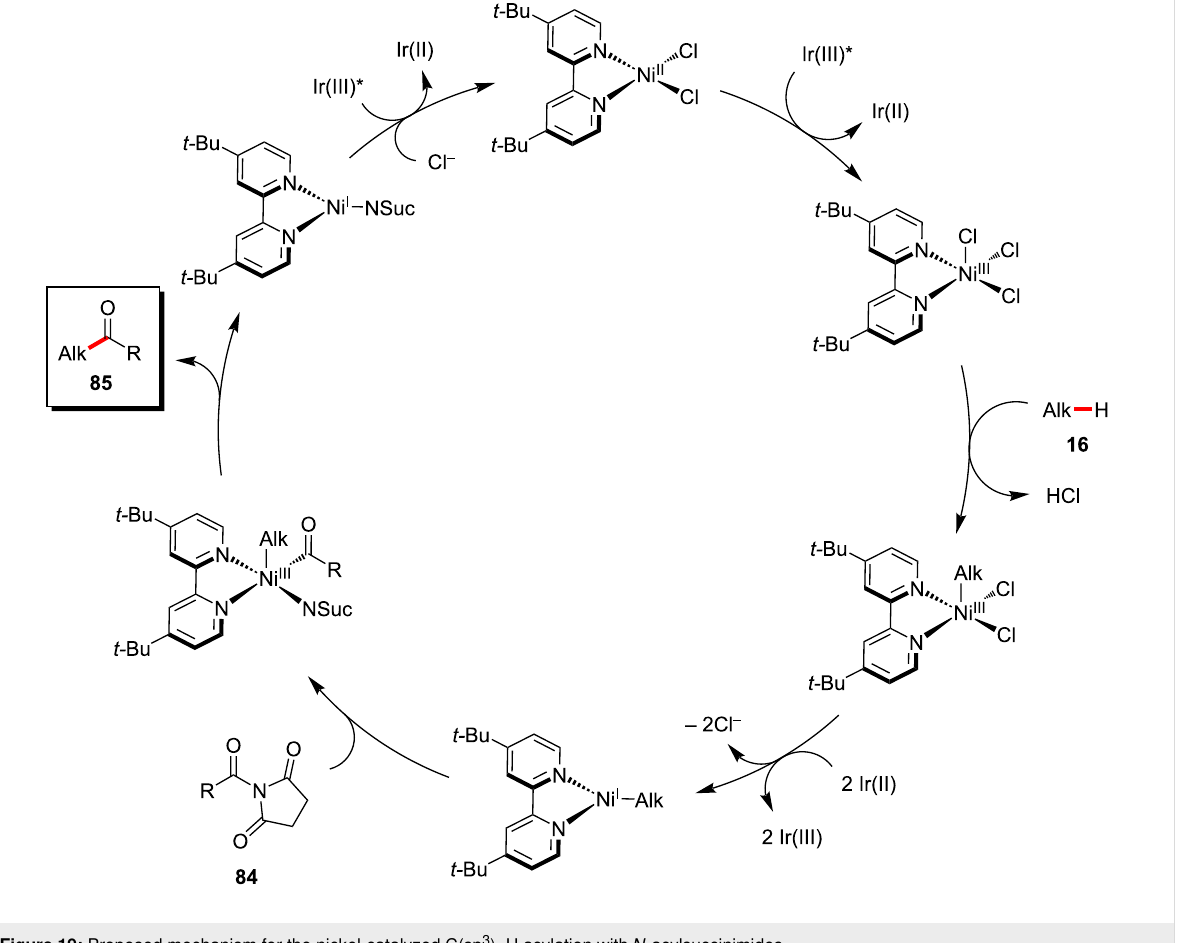
Figure 19: Proposed mechanism for the nickel-catalyzed C(sp 3 )–H acylation with N